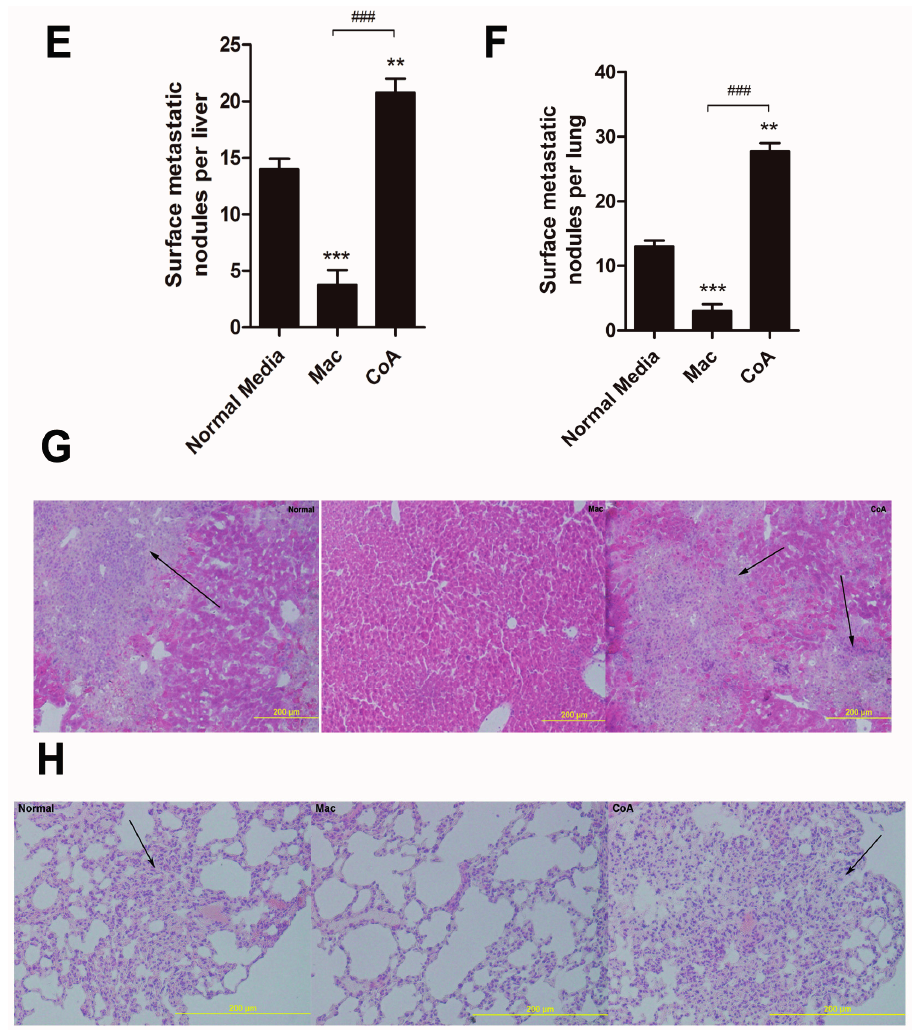
Figure 2. In vivo tumorigenicity and metastatic assay. ( A ) Growth curves for tumors generated by MCF-7 cells grown in three types of conditioned media. The width and diameter of each tumor were measured using calipers, and tumor volume was calculated using the formula ½ × a × b 2 , where “a” is the longer tumor axis and “b” is the shorter tumor axis; ( B ) Tumor weight was measured after excising from mice, n = 5; ( C ) Images of tumors from the three groups of mice; ( D ) Macroscopic view of nodules in the lungs from the three groups of mice; ( E , F ) Quantification of the metastatic nodules in the three groups of mice ( n = 5); ( G , H ) Hematoxylin-eosin (HE) staining of paraffin sections from livers and the lungs of the three groups of mice. Metastases are indicated by the black arrows. ** p < 0.01, *** p < 0.001 vs. Normal media group; ### p < 0.001 vs. Mac group. 2.3. Macrophage Co-Culture with Apoptotic MCF-7 Cells Promotes the Proliferative Ability of CD44 + /CD24 − Cancer Stem-Like Cells and Up-Regulates the Expression of Mucin 1 The tumorigenicity of cancer cells depends on the proportion and activity of cancer stem cells. The proportion of cancer stem cells in the tumor depends on the proliferative ability of both the cancer stem cells and the non-stem cells. CD44 + /CD24 − cells have stem cell-like properties [19] and were used